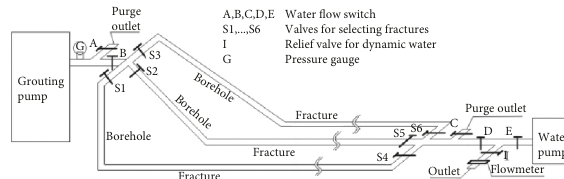
Figure 3: Test device for simulating fractures and boreholes with three dip